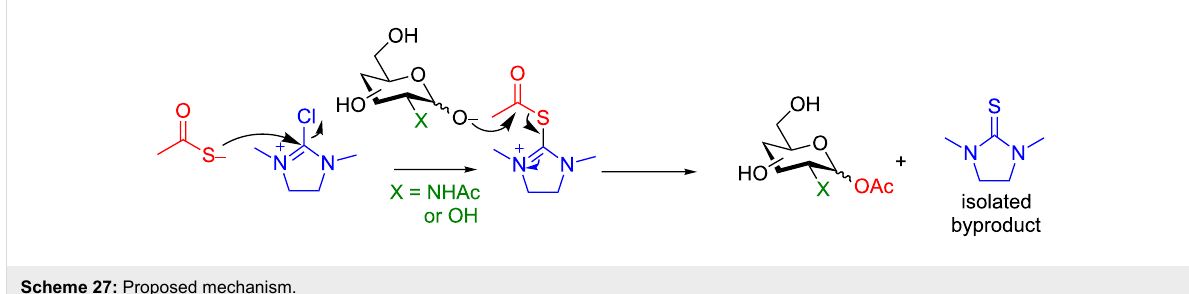
Table 6: Protecting group-free acetylation of unprotected carbohydrates via activation with DMC.